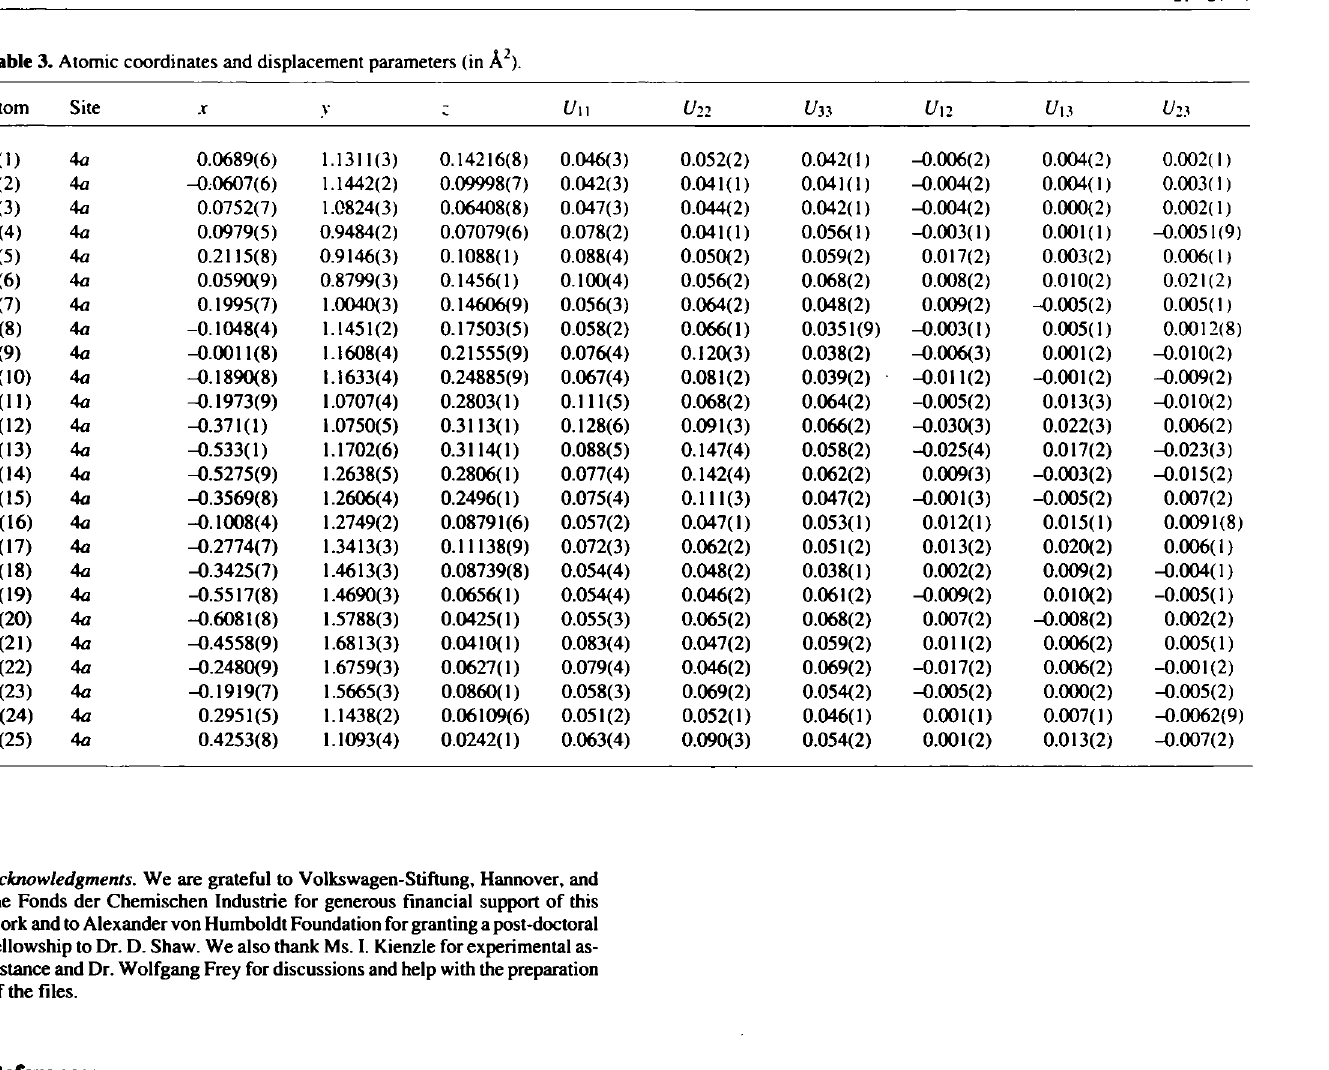
Table 3. Atomic coordinates and displacement parameters (in A 2